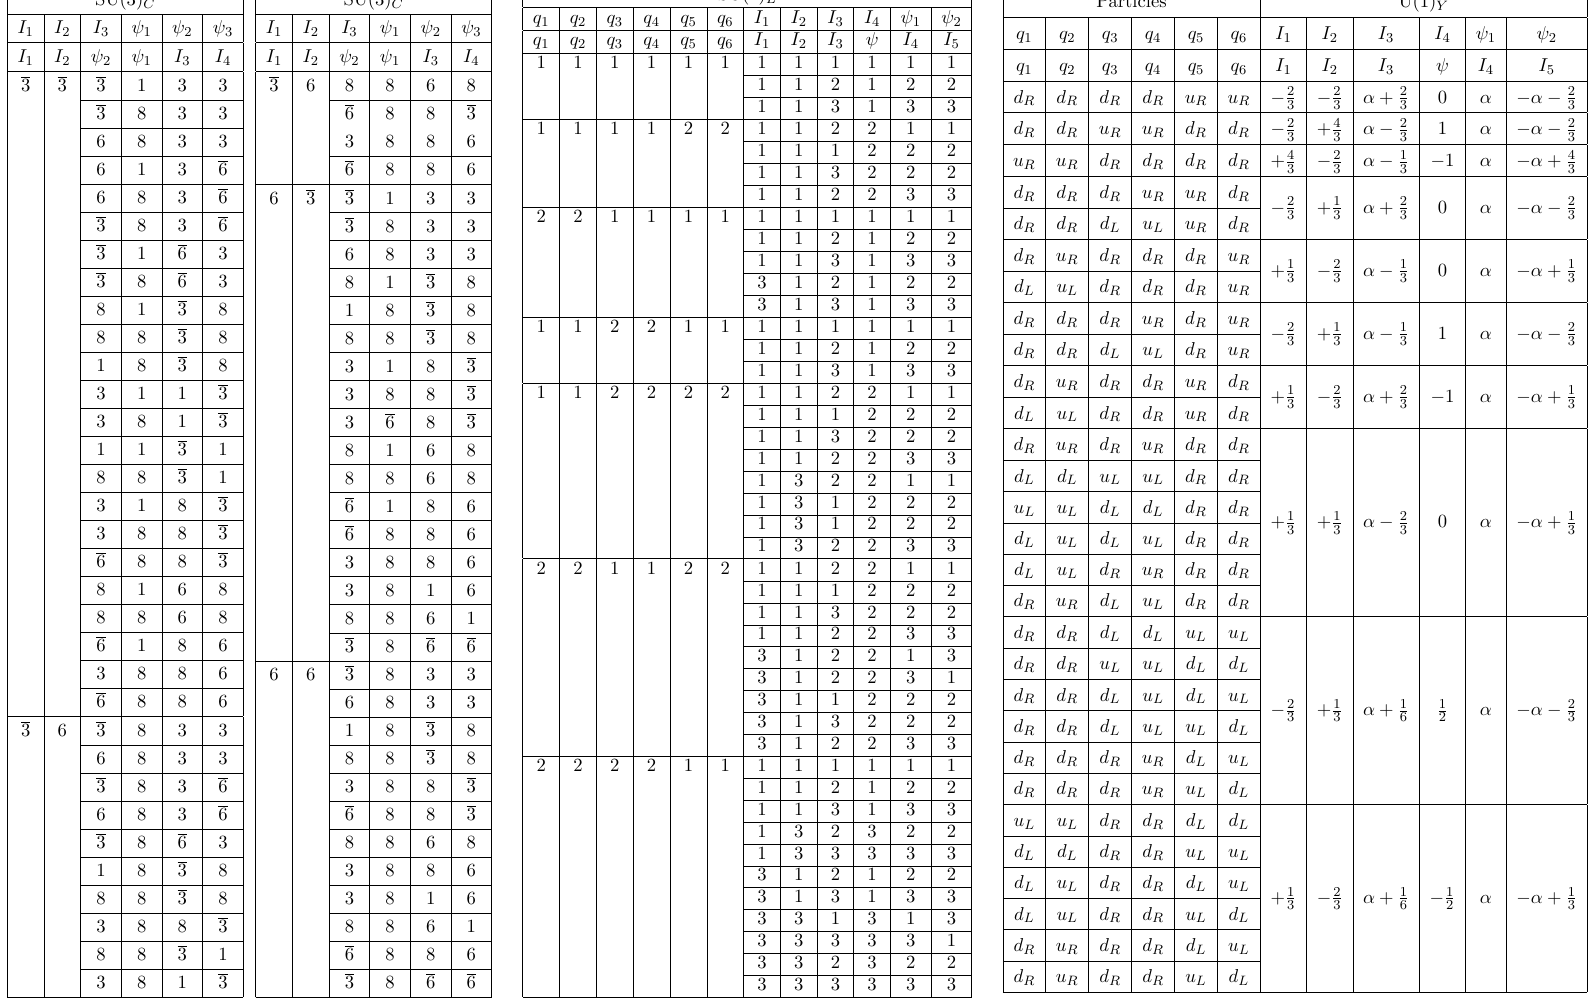
Table 16 . The possible quantum numbers of the fields in Topology-L-11 and